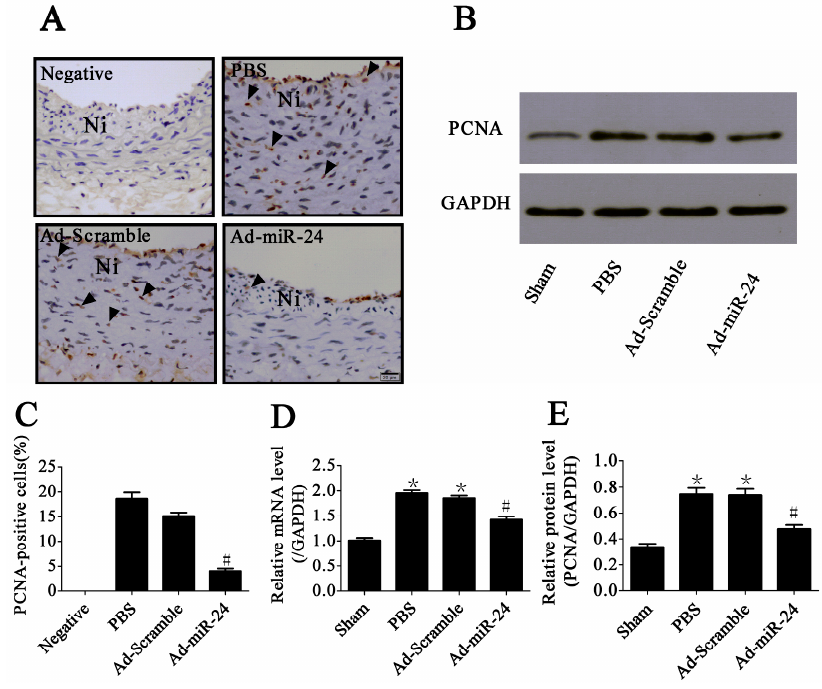
Figure 4. Anti-proliferative effect of miR-24: ( A ) Representative microphotographs of immunohistochemistry for proliferating cell nuclear antigen (PCNA) (400× magnification). Arrows indicate positive cells for PCNA. Ni: Neointima. Scale bar represents 20 μ m; ( B ) Representative immunoblots of PCNA; ( C ) PCNA-positive rate in the neointima (compared to Ad-Scramble group and PBS group, # p < 0.05, n = 6); ( D ) The mRNA level of PCNA in carotid artery (compared to Sham group, * p < 0.05; compared to PBS group or Ad-Scramble group, # p < 0.05, n = 6); ( E ) Bar graphs of corresponding densitometric analyses of Western blots (compared to Sham group, * p < 0.05; compared to PBS group or Ad-Scramble group, # p < 0.05, n = 6).